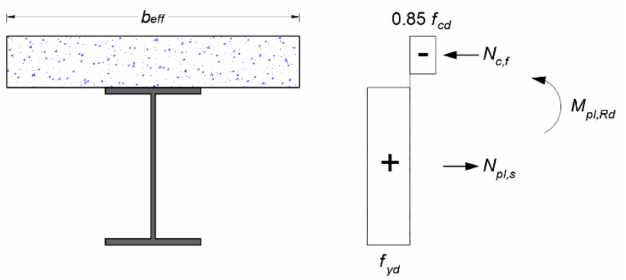
Figure 1. Typical plastic stress distributions for a composite beam in positive bending.